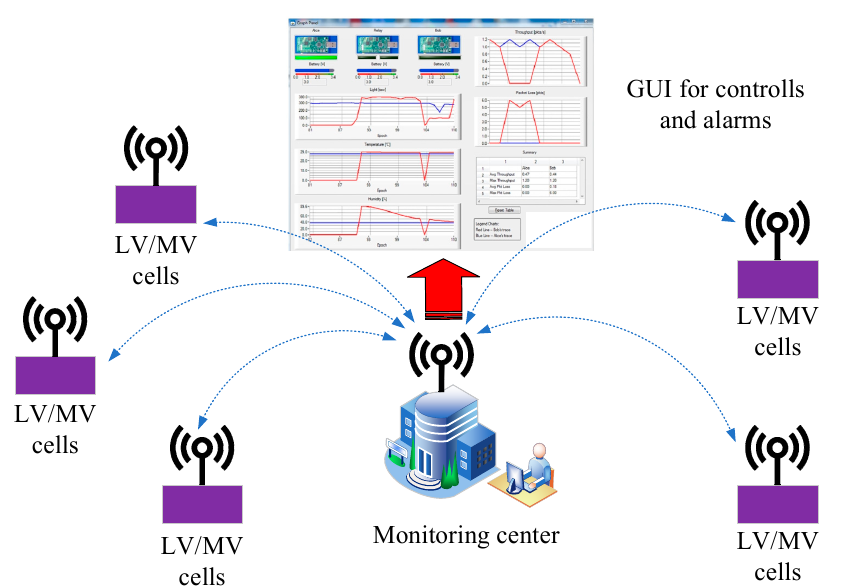
Figure 9. Communication flowchart proposal for microclimate monitoring in LV/MV switchgear .